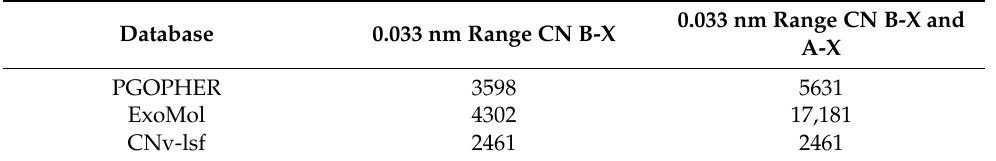
Table 6. Number of transitions of the simulated spectra in the measured experimental ranges for the